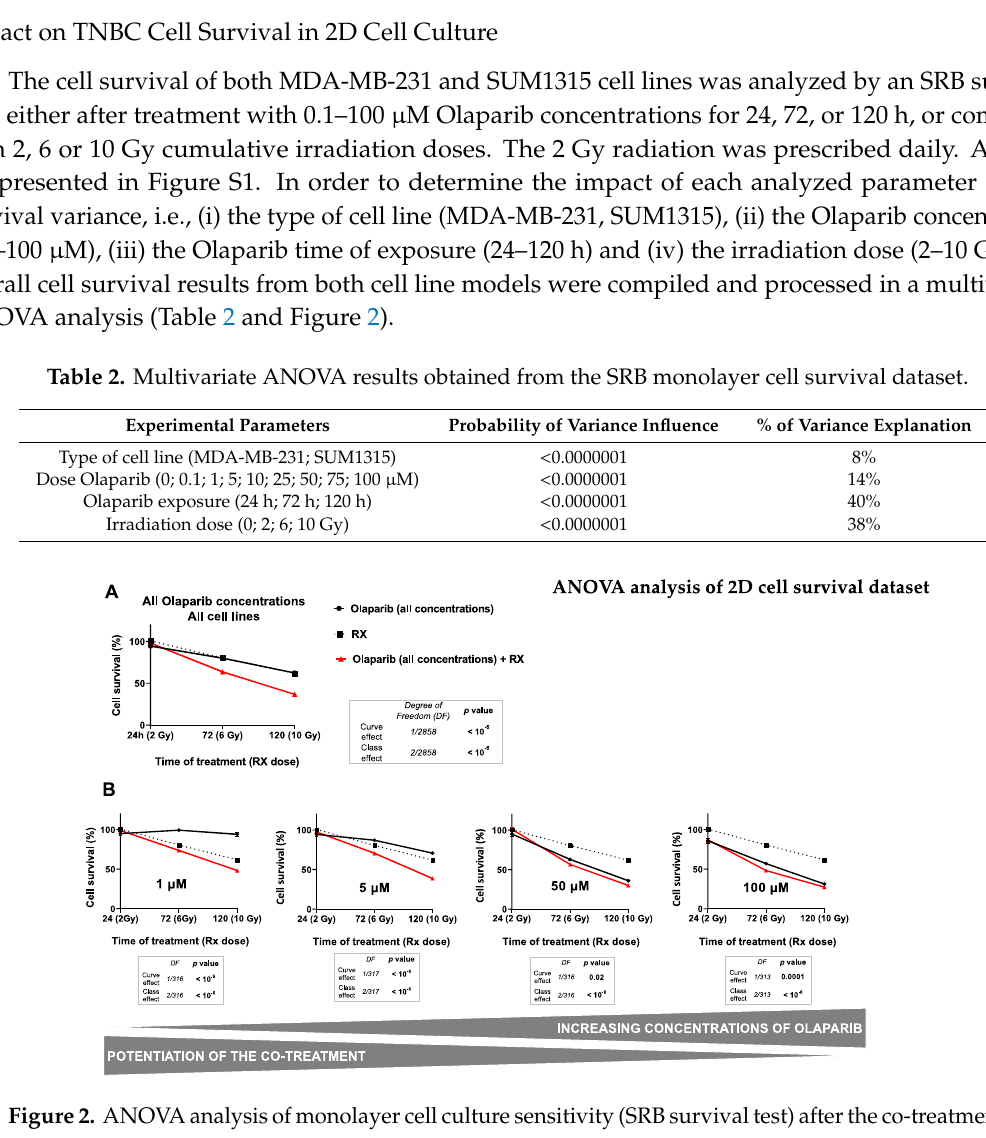
Table 2. Multivariate ANOVA results obtained from the SRB monolayer cell survival dataset. Experimental Parameters